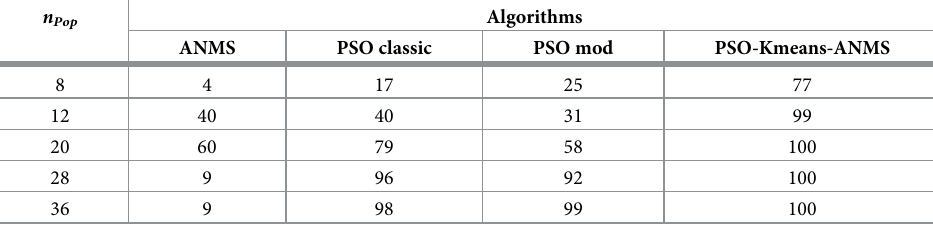
Table 5. Population versus success rate for the Rastrigin function. Percentage success rate sr (%) for each algorithm referring to swarm sizes with 8, 12, 20, 28 and 36 particles. n Pop